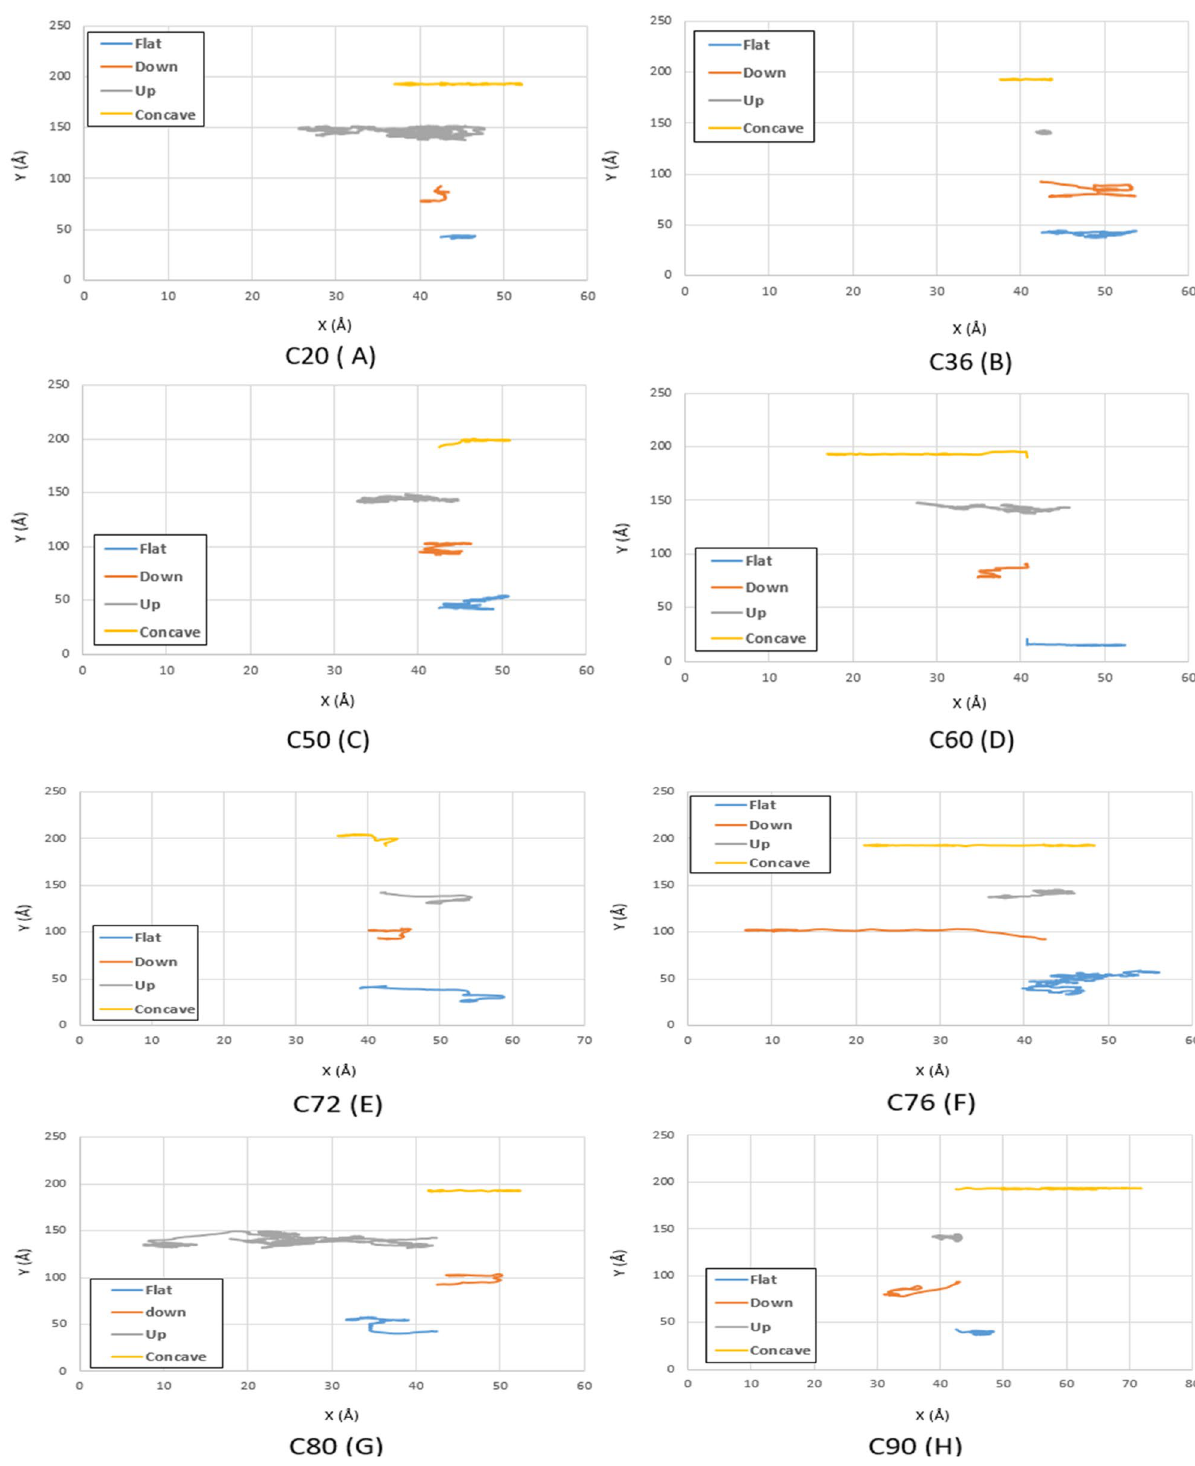
Figure 3. Trajectories of different fullerenes on a gold substrate at 75 K for C 20 ( A ), C 36 ( B ), C 50 ( C ), C 60 ( D ), C 72 ( E ), C 76 ( F ), C 80 ( G ), and C 90 ( H . The blue, red, black and yellow lines show the trajectories of the molecules on the flat, down side of the step, top side of the step, and concave substrates,